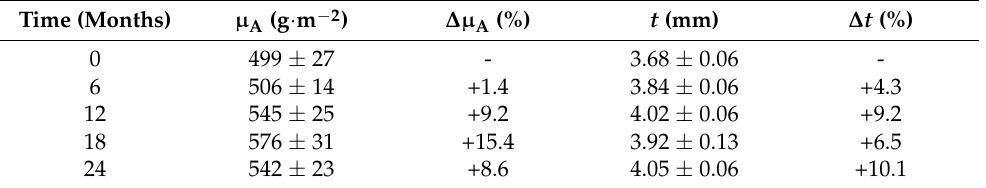
Table 4. Physical properties of GT500 before and after the field weathering tests. (Notation: µ A – mass per unit area; ∆ µ A – variation in mass per unit area; t – thickness; ∆ t – variation in thickness). Time (Months)